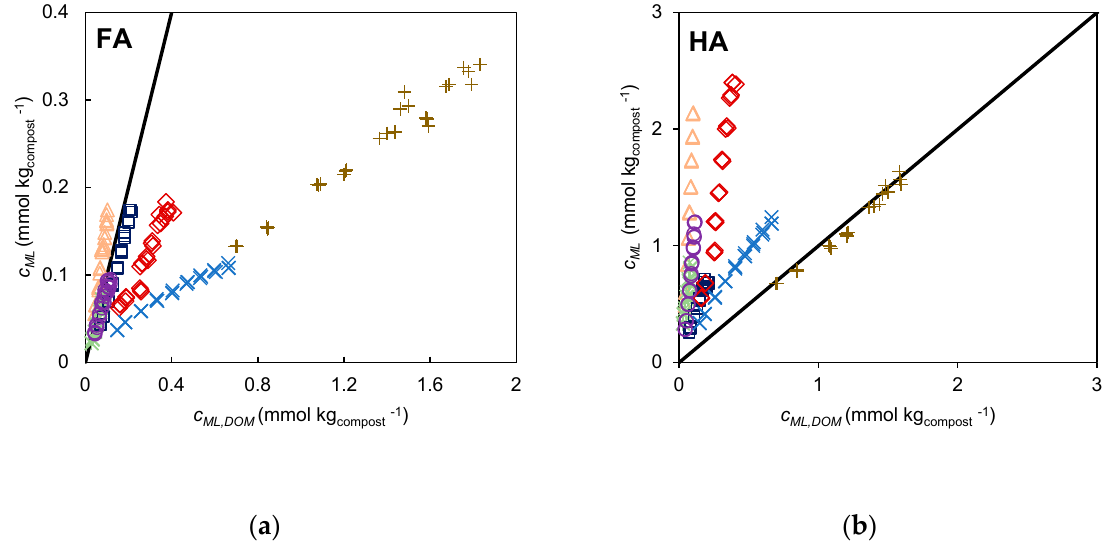
Figure 4. Comparison of Cd 2+ binding data at pH 7.0 and ionic strength 12 mmol L − 1 in NaNO 3 and HNO 3 for: ( a ) FA vs. DOM and ( b ) HA vs. DOM of composts: CDDW (purple ( )), CVDW (red ( ◇ )), CVA (green ( ) ), CA (coral ( )), CUW (blue ( )), CSS (dark blue ( )), CLW (brown ( )). The y = x line represents the equivalence between results.